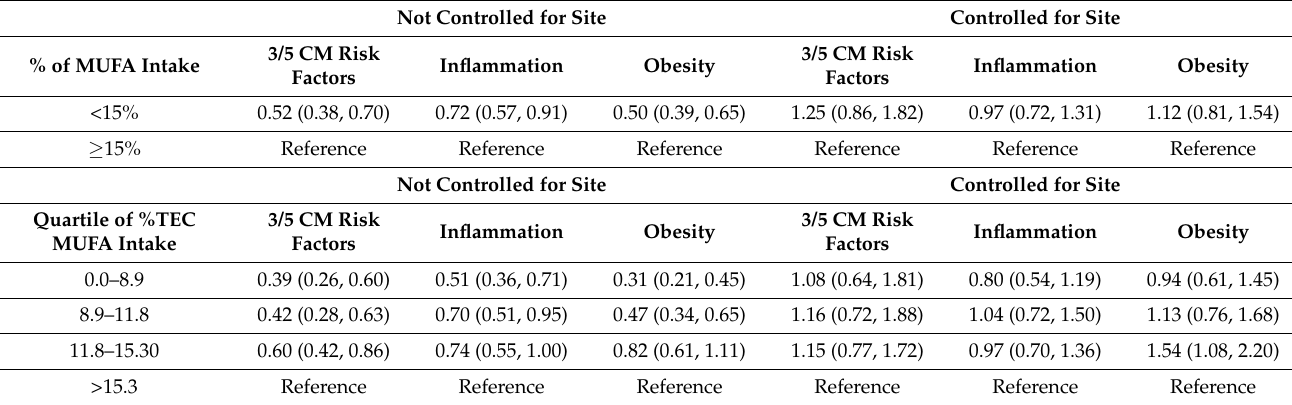
Table 5. Adjusted odds ratios for cardiometabolic risk based on %TEC monounsaturated fatty acids <15% and >15% in four countries across the epidemiological